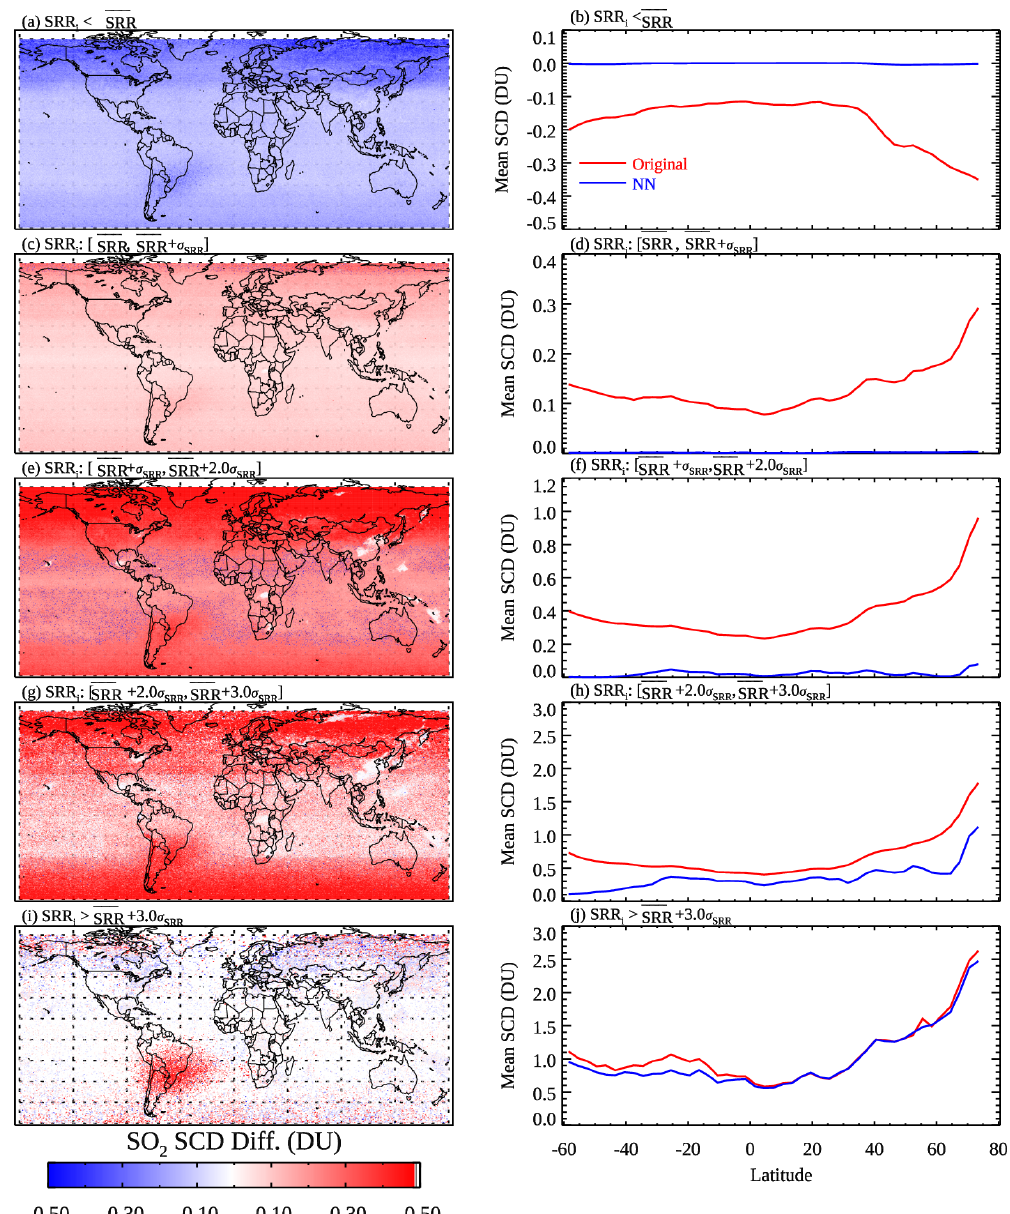
Figure 7. (a, c, e, g, i) The differences between the original and NN-analyzed OMI SO 2 SCDs for March 2005. (b, d, f, h, j) The mean (red) original and (blue) NN-analyzed SCDs for 3 ◦ latitude bands for the same month. Different rows show results from pixels that have SCD / rms ratios (SRR i ) within different ranges based on the monthly medians of the daily mean (SRR) and standard deviation ( σ SRR ) of SRRs for their corresponding latitude bands: (a–b) SRR i < SRR, (c–d) SRR < SRR i < SRR + σ SRR , (e–f) SRR + σ SRR < SRR i < SRR + 2 σ SRR , (g–h) SRR + 2 σ SRR < SRR i < SRR + 3 σ SRR , and (i–j) SRR i > SRR + 3 σ SRR